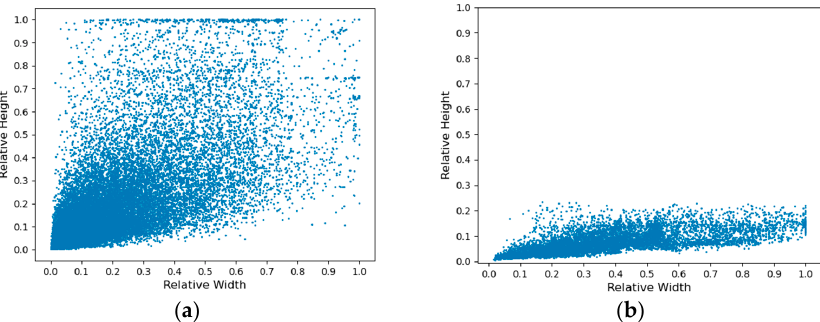
Figure 3. Relative shape of targets under different data sets; ( a ) CoCo dataset target box relative value; ( b ) relative value of SeaShips dataset target box. value; ( b ) relative value of SeaShips dataset target box.